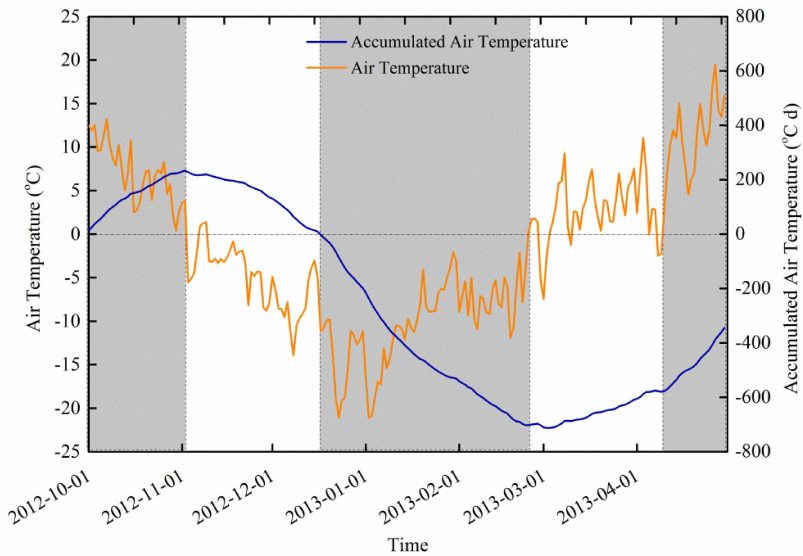
Figure 1. Air temperature variation and period divisions. The blue line is accumulated air temperature, and the orange line is air